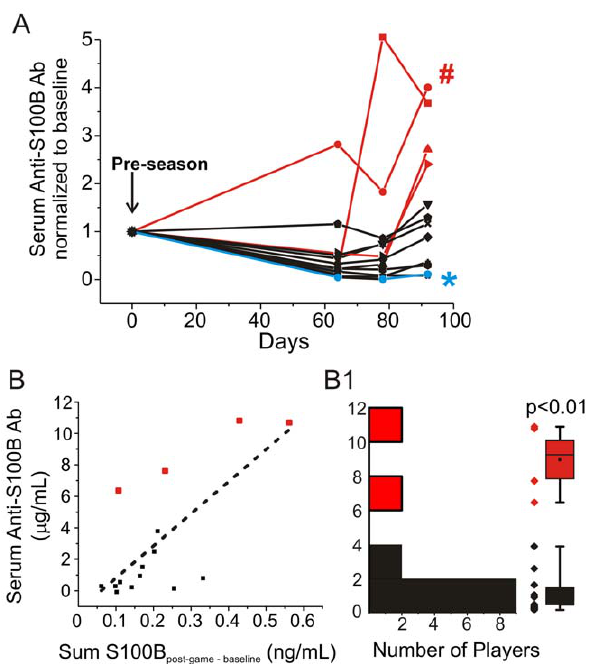
Figure 4. Serum anti-S100B antibody levels in football players before and after a season. A ) Time course of auto-S100BAb in blood. Auto-S100Ab were measured at baseline and at time (days from the baseline) corresponding to the last three games of the season. Data were normalized by the baseline auto-S100B Ab values. B ) Significant correlation between serum anti-S100B Ab measured at the end of the season and the cumulative (5 games) S100B post-game – baseline values (see text for details). C ) Bimodal distribution of players’ anti-S100BAb titer at the end of the season. The robustness of the methods employed to detect auto-antibodies was verified as shown in Table